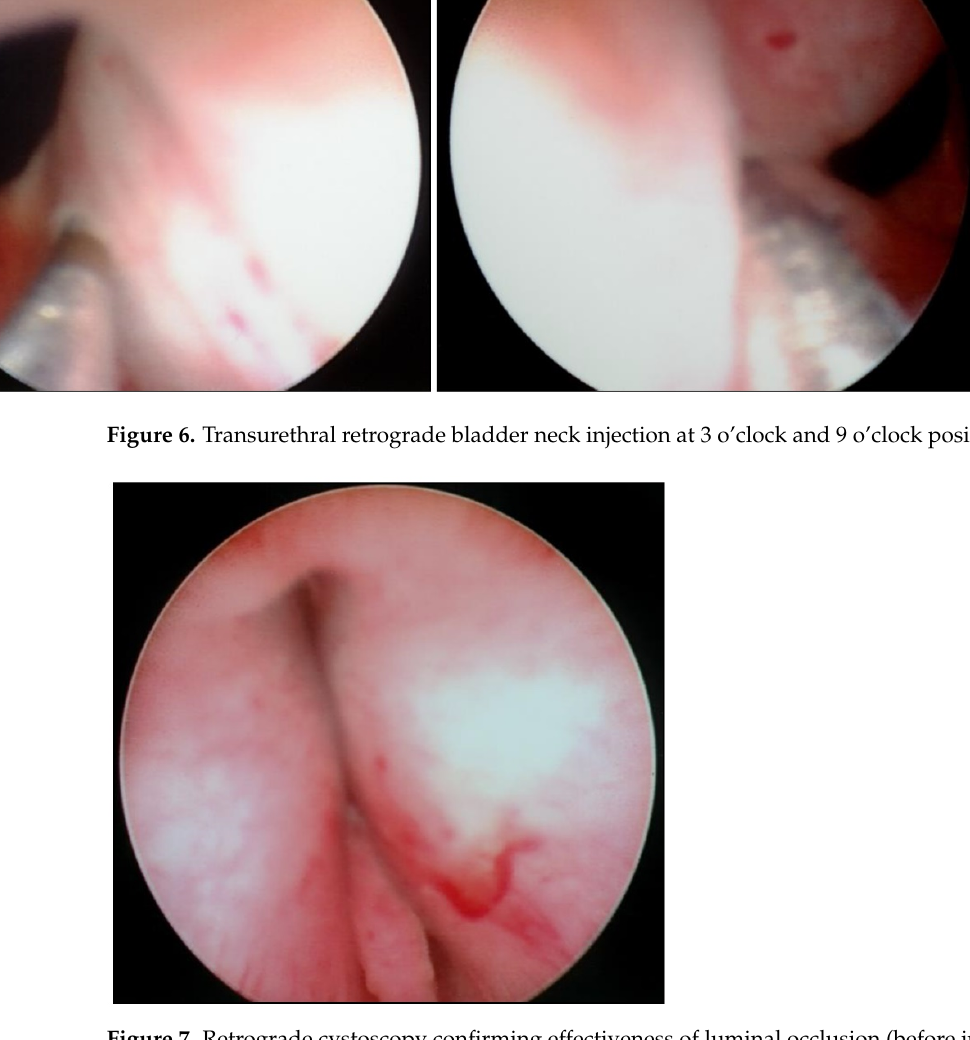
Figure 7. Retrograde cystoscopy confirming effectiveness of luminal occlusion (before injection: see Figure 5).